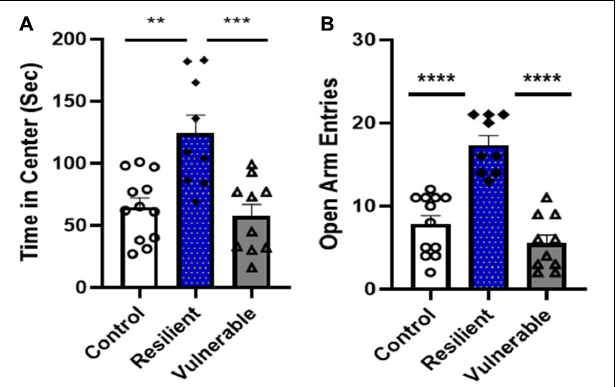
FIGURE 8 | A separate cohort of rats were tested for anxiety-like behaviors on the open field test and elevated plus maze after control handling or SPS exposure. SPS rats were classified as vulnerable or resilient based on anxiety scores using the algorithm developed. (A) During open field, the resilient group spent significantly more time in center of the open field test than the vulnerable group (*** P < 0.001) and control group (** P < 0.01). (B) The elevated plus maze test showed the resilient group had significantly higher open arm entries than the vulnerable (**** P < 0.0001) or control (**** P < 0.0001) groups. Data are expressed as means ± SEM; controls N = 12, resilient N = 9, vulnerable N =